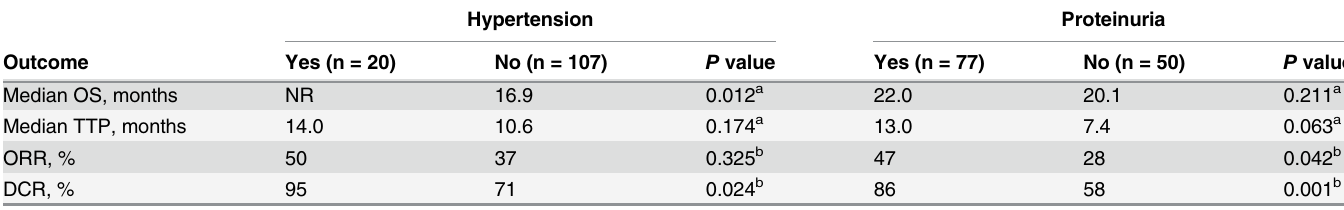
Abbreviation: DCR = disease-control rate; NR = not reached; ORR = overall response rate; OS = overall survival; TTP = time to progression.